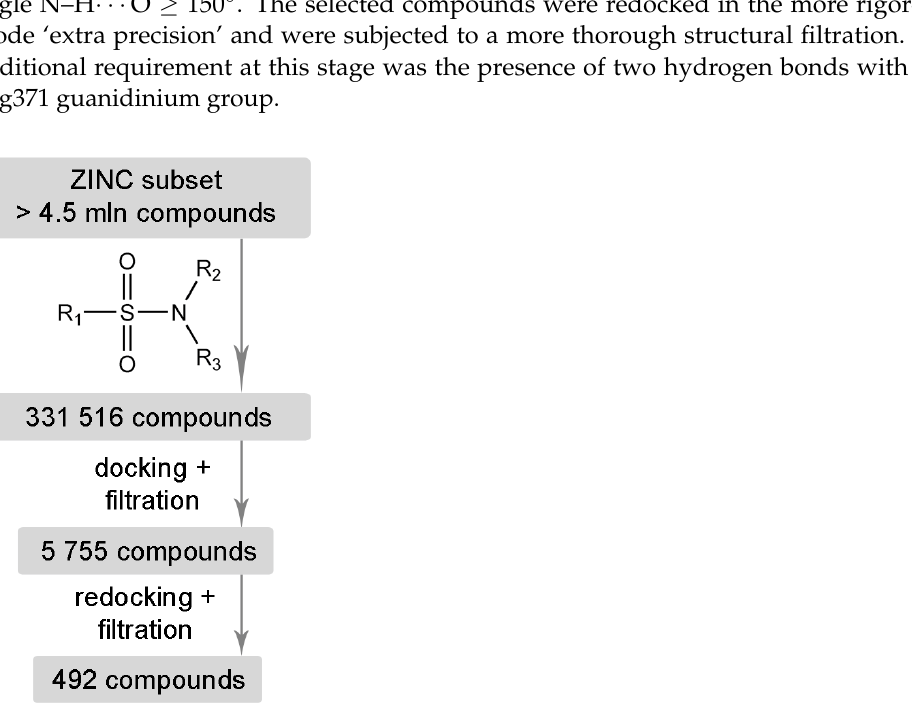
Figure 7. Schematic representation of virtual screening of compounds from the ZINC12 library against N1 neuraminidase.